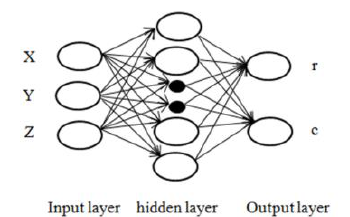
Figure 1. Network Perceptron with a Hidden Layer for the geometric modelling of satellite images